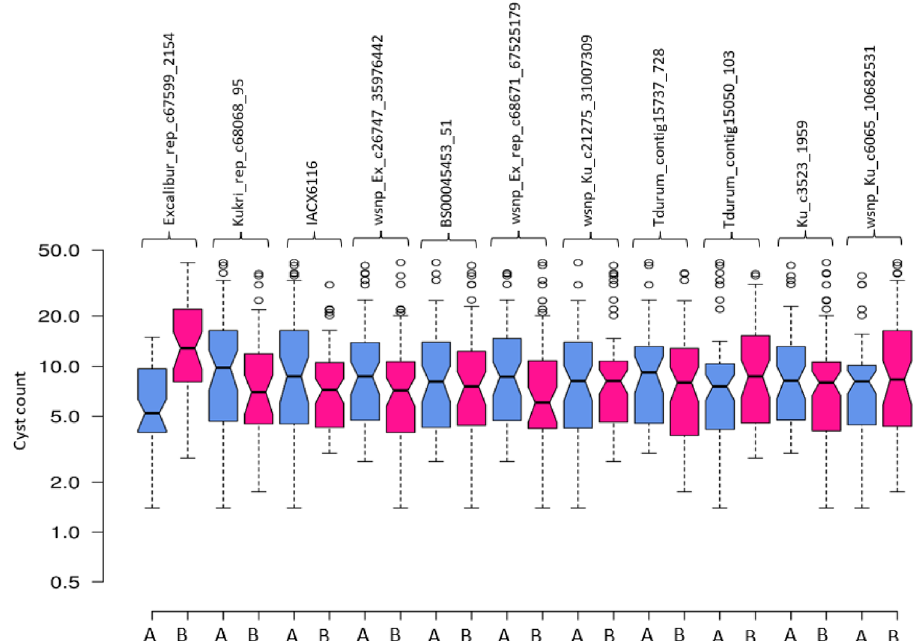
Figure 5. Box plots showing alleles contributing resistance or susceptibility for Heterodera avenae . The phenotypic value (cysts count) of 11 significant marker alleles for H. avenae resistance QTLs detected in Y1, Y2 and CY was selected to calculate the allelic effect. Center lines show the medians; box limits indicate the 25th and 75th percentiles; whiskers extend to 5th and 95th percentiles, outliers are represented by